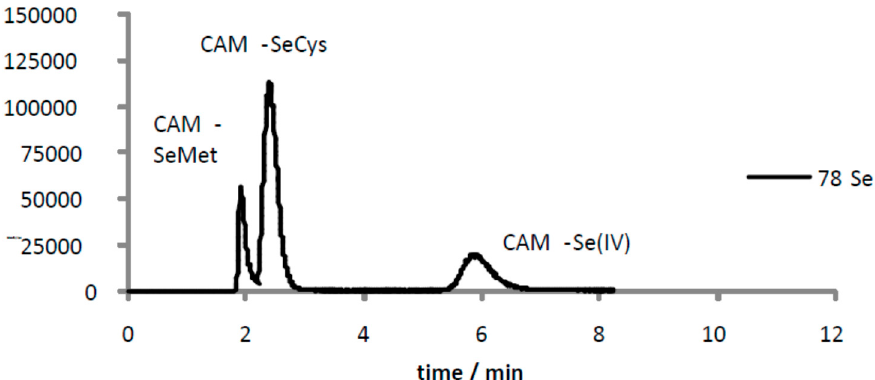
Figure 6. Anion exchange HPLC-ICP-MS chromatograms of hydrolyzed extracts of CS-SeNPs bacterial cell pellet after exposure to 10 μ g Se mL − 1 as Cs-SeNPs obtained by carbamidomethylation following by enzymatic hydrolysis. CAM-SeCys: carbomethylated selenocysteine; CAM-SeMet: carbomethylated selenomethionine; and CAM-Se(IV): carbomethylated selenite. Measurements were performed by monitoring 78 Se isotope.